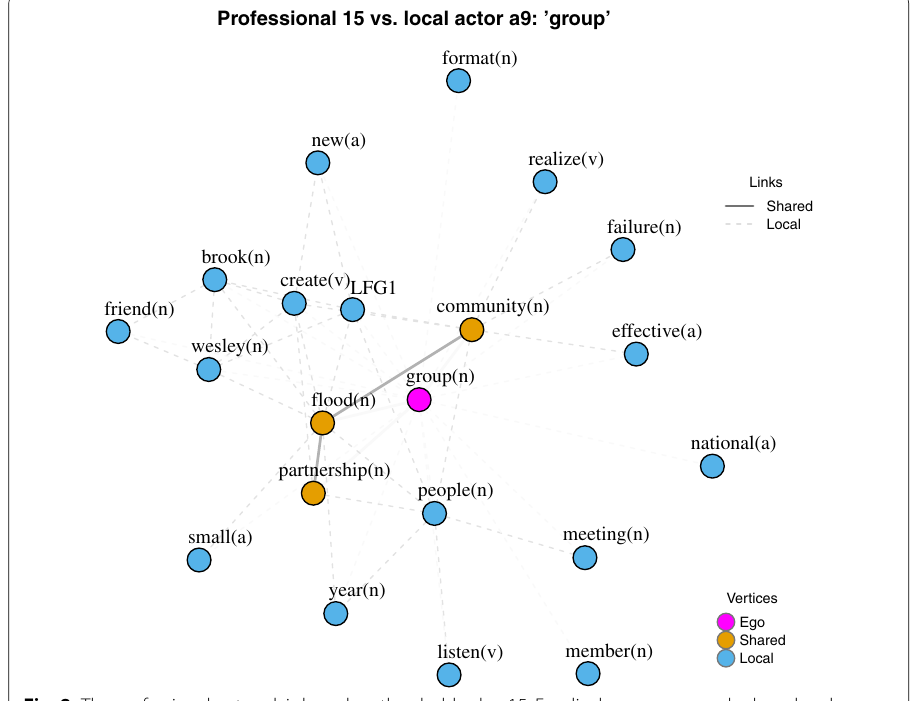
Fig. 8 The professional network is based on threshold value 15. For display purposes, only shared and local-specific concepts are shown